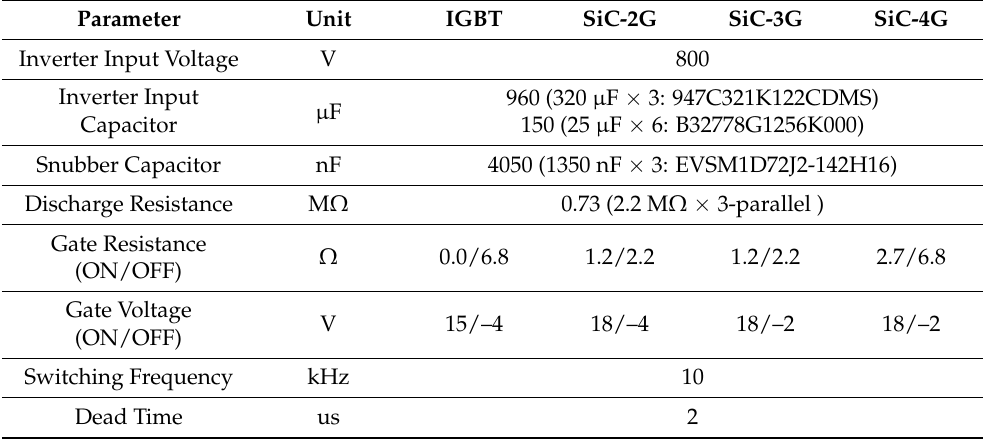
Table 3. Parameters of driven